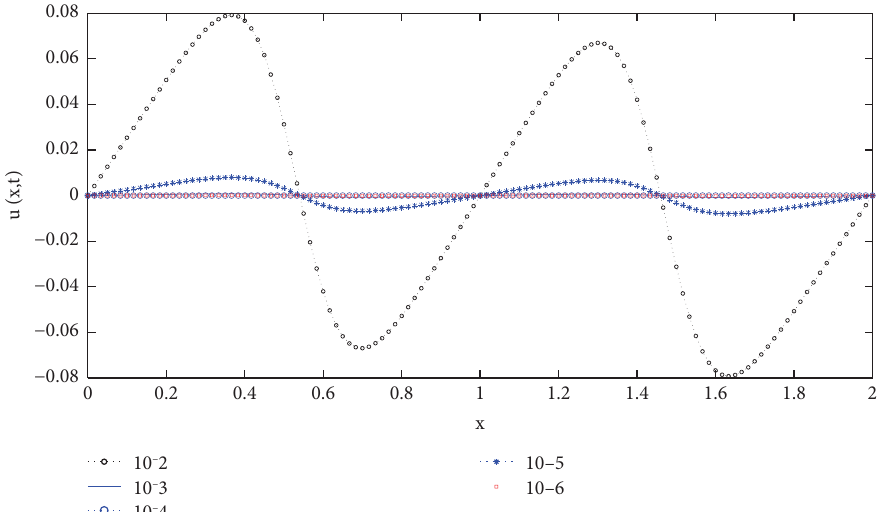
Figure 3: Physical behaviour of the solution of the second test problem obtained at t � 1 for diferent values of ] . T=1